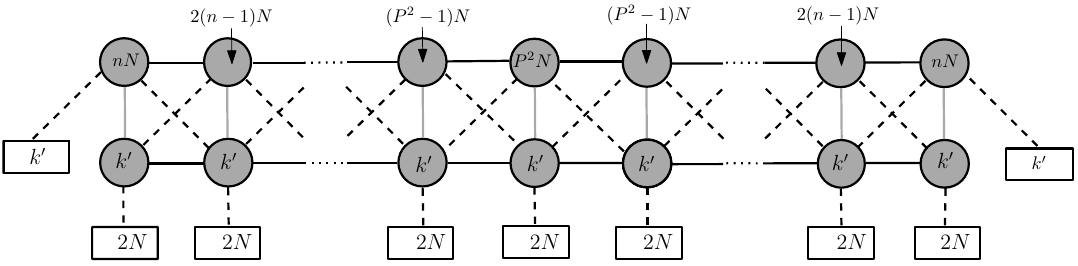
Figure 3 . 2d quiver CFT dual to the AdS 3 × S 3 / Z k × S 2 solution asymptotically locally AdS 7 / Z k